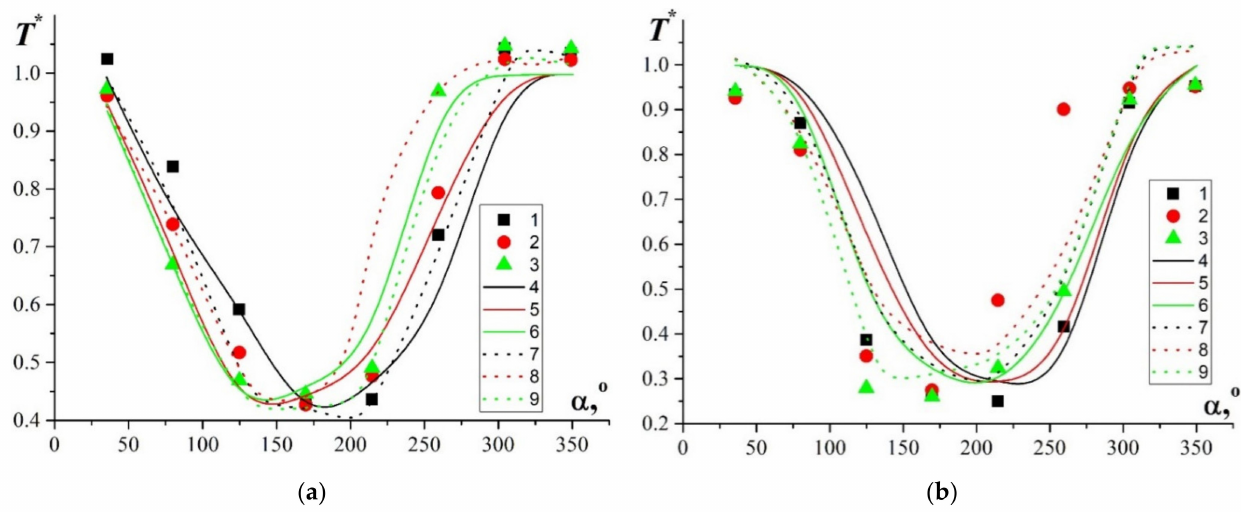
Figure 14. Profiles of the dimensionless temperature T* obtained experimentally [12] (symbols), by the LES approach [12] (dashed lines) and by the RANS approach (solid lines): regime ST1 ( a ), regime ST2 ( b ): 1, 4, 7—Section 5 D m ; 2, 5, 8—Section 5.5 D m ; 3, 6, 9—Section 6 D